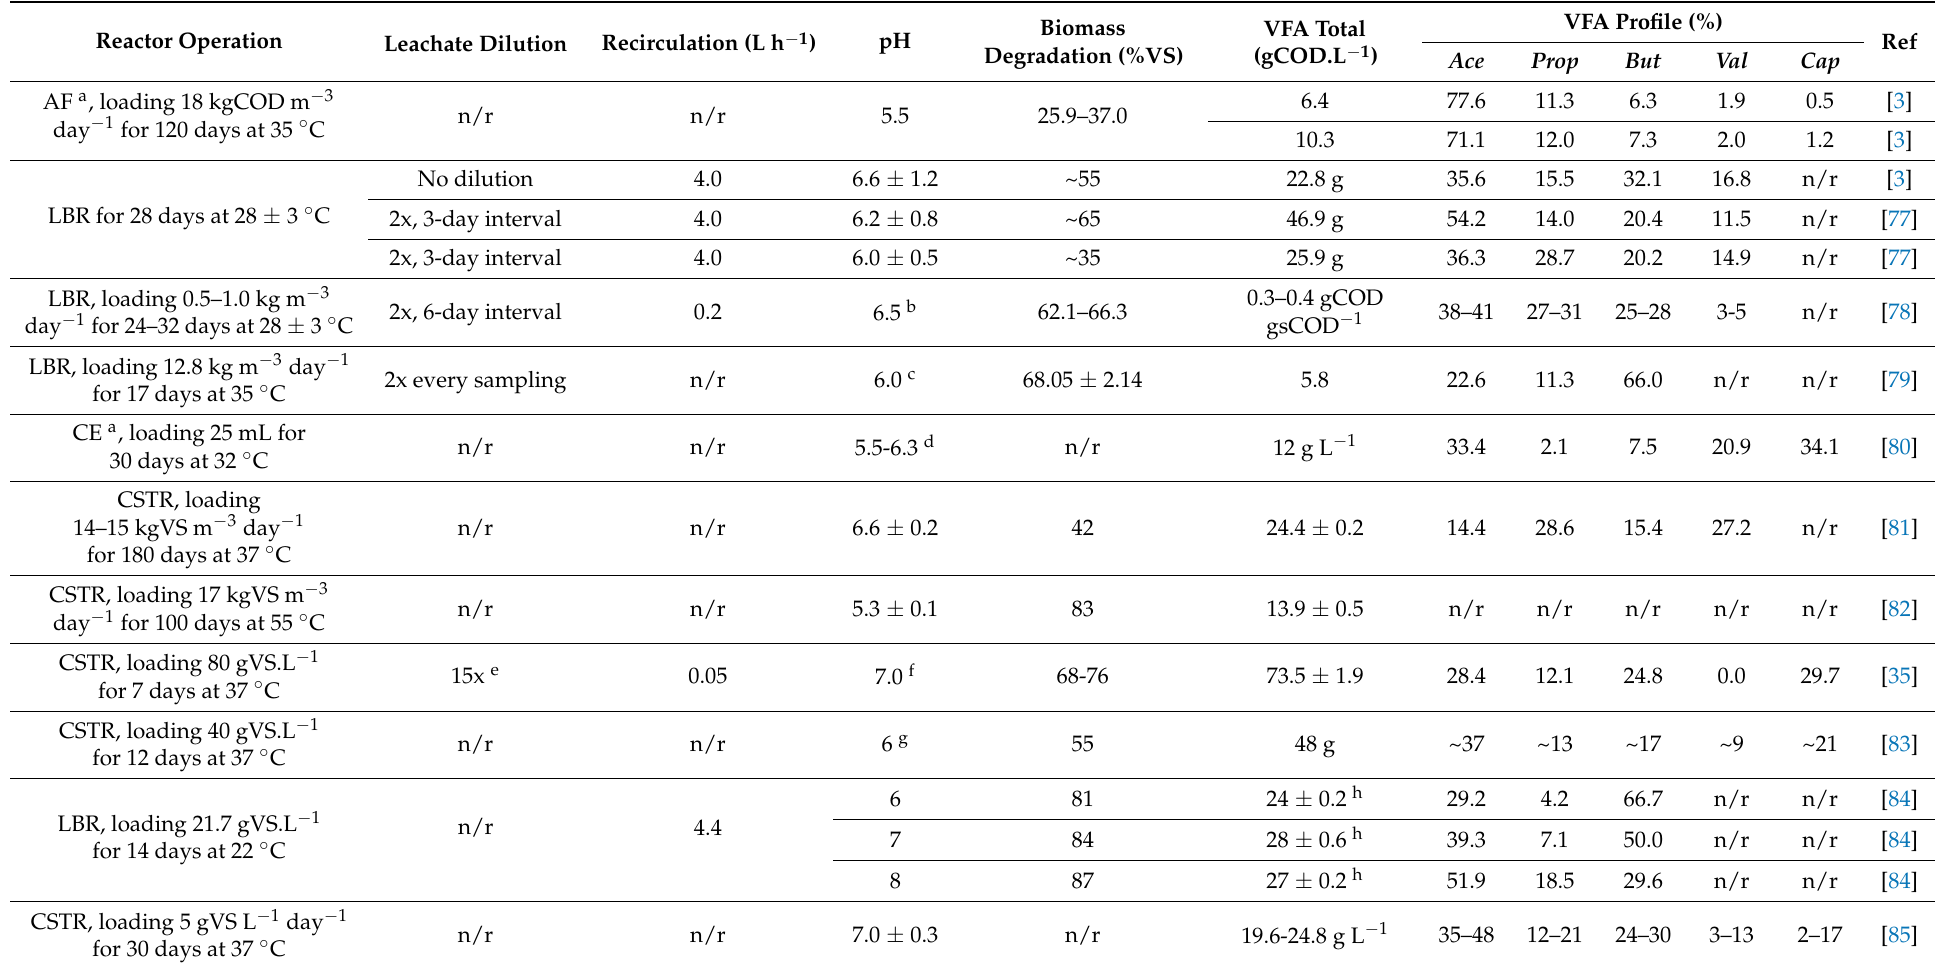
Table 2. Summary of the operational conditions for VFA production using the raw materials described in Table